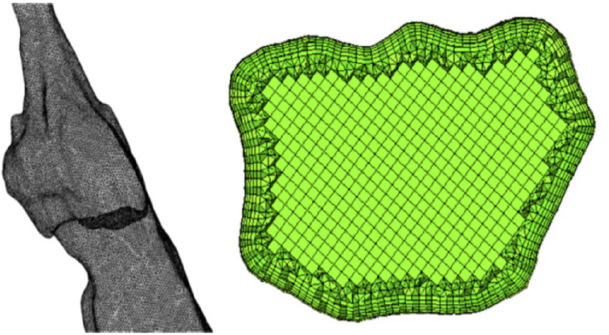
Figure 6. Hybrid meshing of a UA model Reprinted with permission from Ref. [43]. 2013, Moyin Zhao et al.